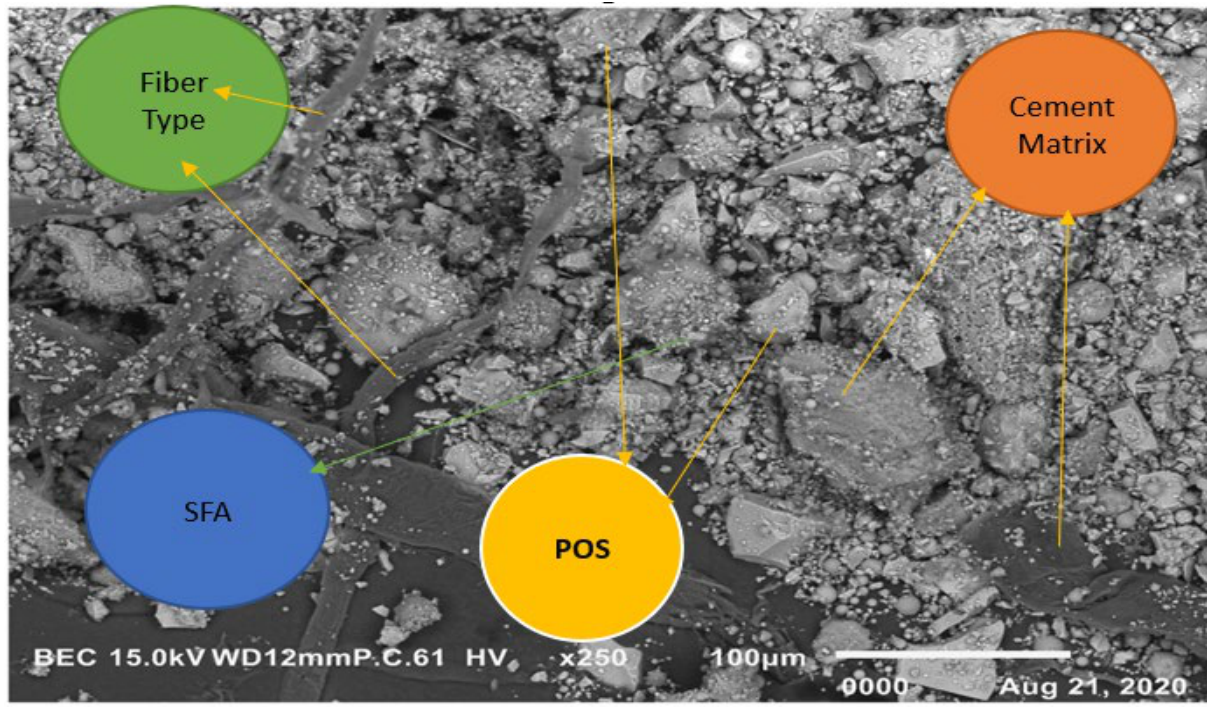
Figure 16. SEM image—EDS mapping on a 100 µm scale. Table 11. Summary of ANOVA